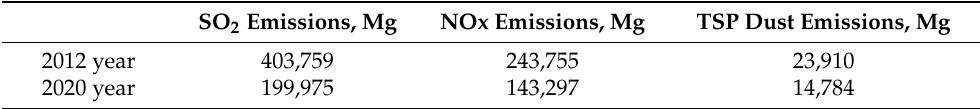
Table 1. Projected emissions from large combustion plants (as defined in the IED Directive). Own study based on [4], TSP-total suspended